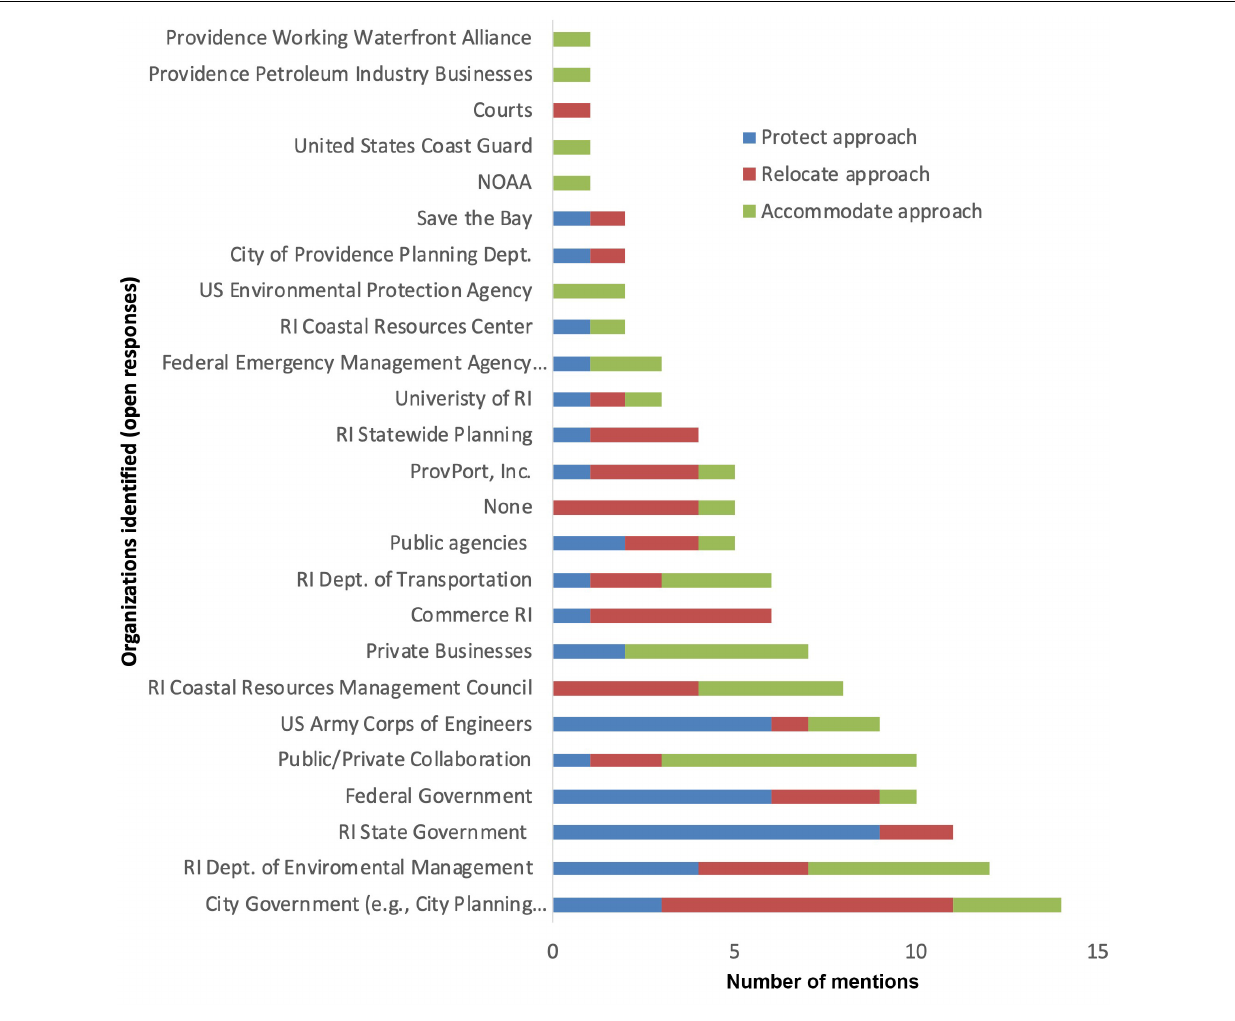
FIGURE 5 | Survey respondents from the public sector ( n = 12) and private sector ( n = 13) identified 25 organizations that they felt should take a leadership role for planning and investing in the three broad resilience approaches. A total of 131 responses to the open-ended question were received from the 25 survey